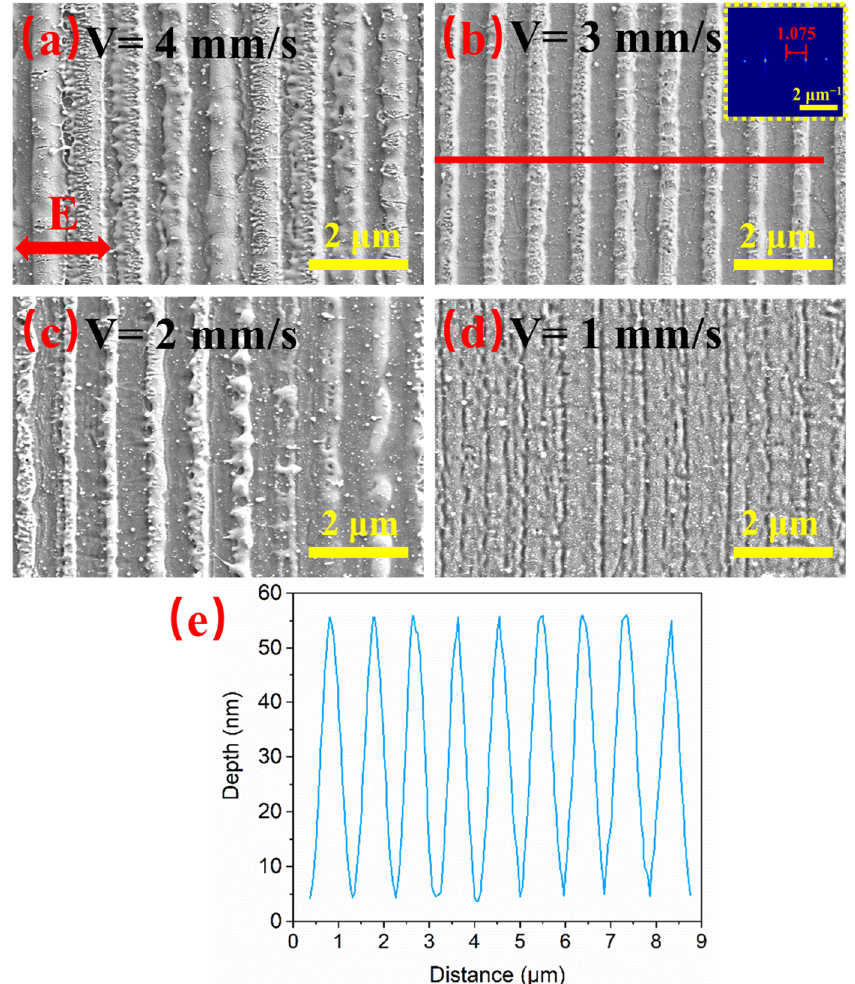
Figure 7. SEM images of LSFLs on the ITO film after laser irradiation under scanning velocities of ( a ) 4, ( b ) 3, ( c ) 2 and ( d ) 1 mm/s with a fixed pulse fluence of 0.66 J/cm 2 . The scale bars are all 2 µm. The FT of ( b ) is highlighted in the inset. ( e ) shows the depth profile along the red line in ( b ). The main components of the ITO film are indium, tin and oxygen. Therefore, the weight percentage of indium ions can be used to characterize the removal of the ITO